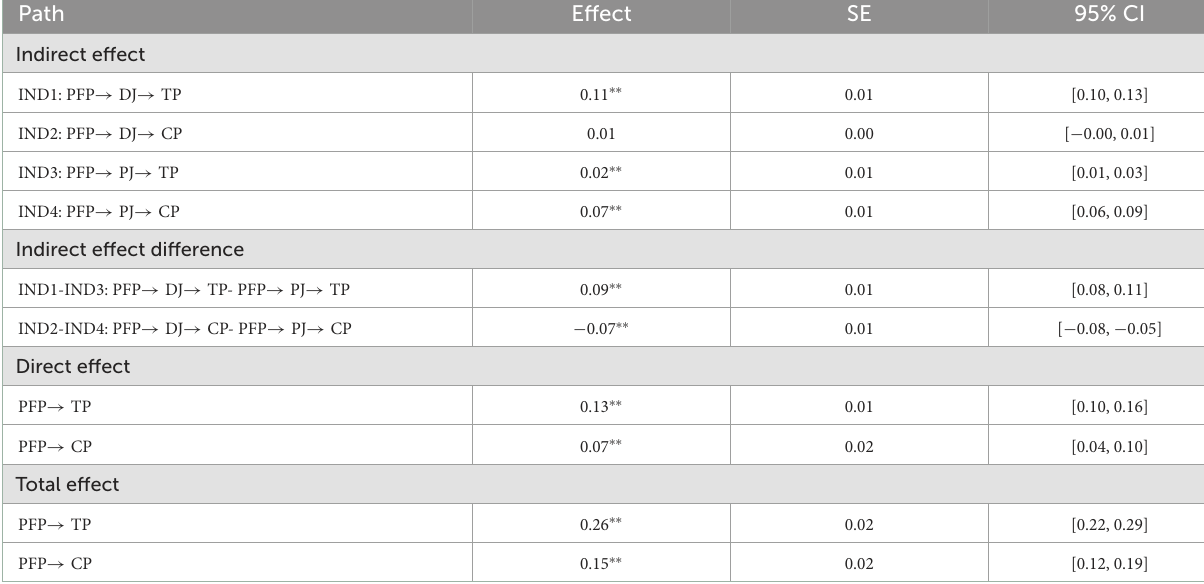
TABLE 5 Tests of mediation for